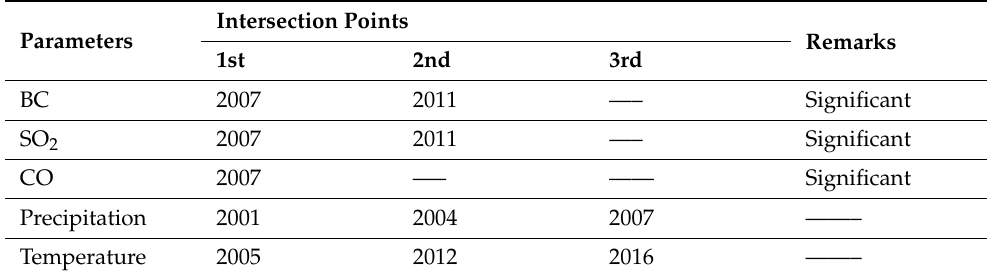
Table 2. Intersection points by sequential Mann–Kendall test for southern Africa (values significant at p ≤